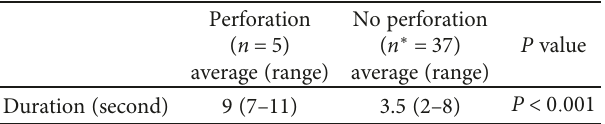
Table 4: Total duration of cautery needed for hemostasis by comparison between perforated points and nonperforated points in fi ve cases.